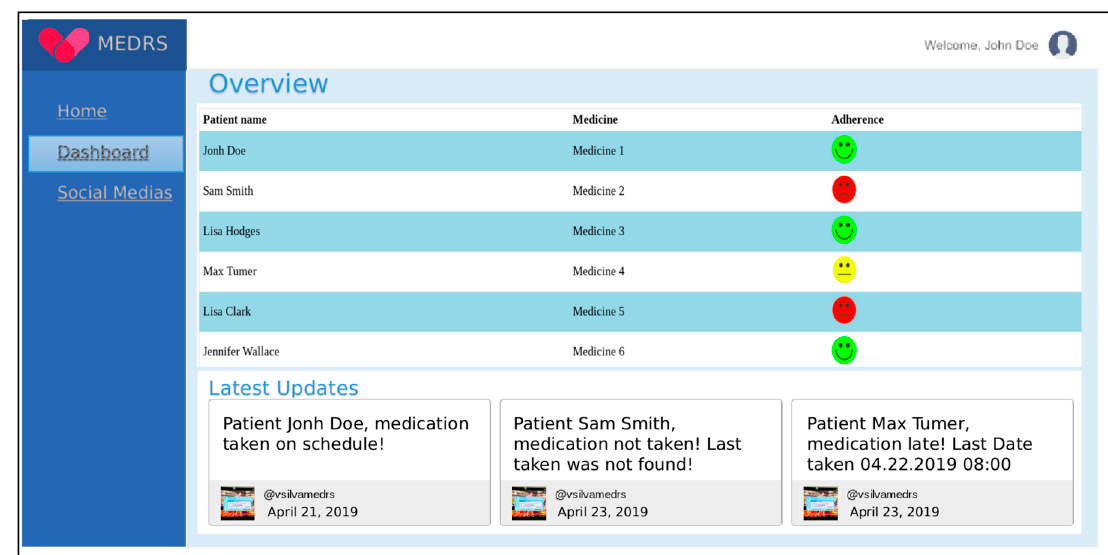
Figure 7. Mobile website integrated with Twitter.